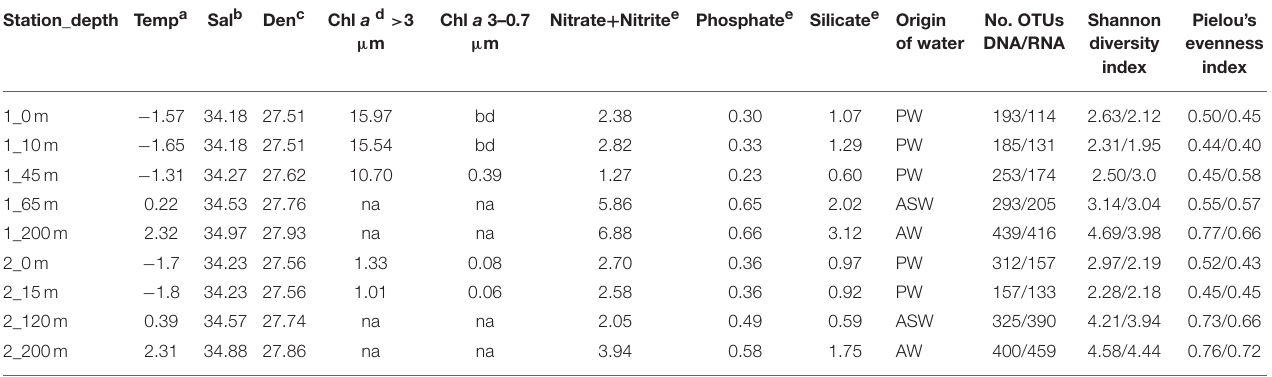
TABLE 1 | Environmental characteristics of the water samples collected from North-West Spitsbergen.